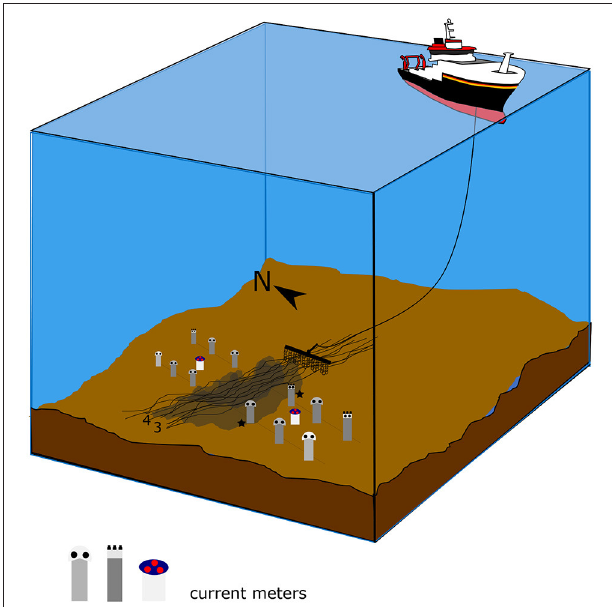
FIGURE 2 | Schematic illustration of the deep-sea dredge experiment and the layout of the sensor array. The observation platforms with different sensors are depicted as four different elements. The monitoring stations marked by stars show the sensors that are used for model validation in our study. Dredge tracks with higher sediment discharge rate are highlighted with the track numbers. Areas of sediment deposition are shown as grey shaded areas. The figure is not